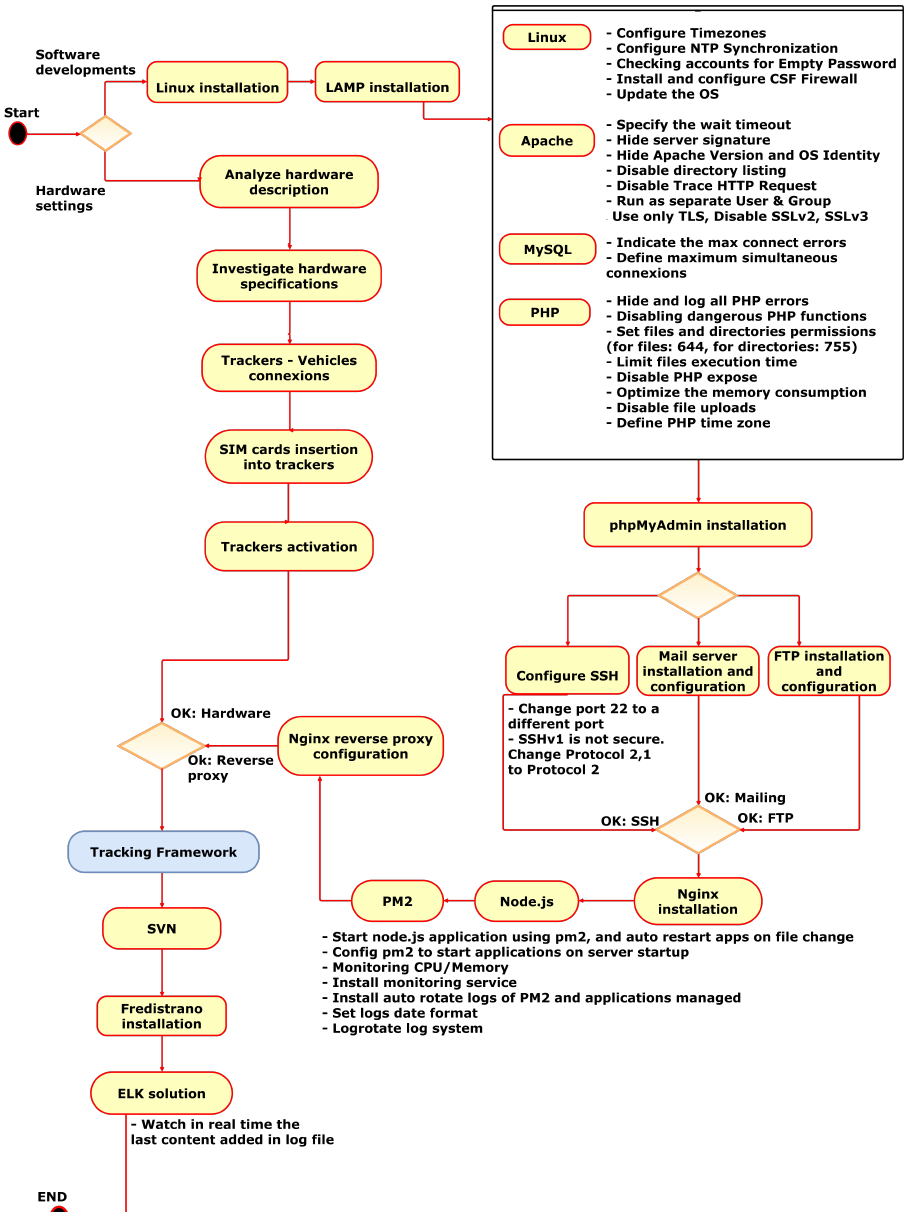
Figure 4. Flow chart describing the processes and procedures required for setting-up the system, its implementation and